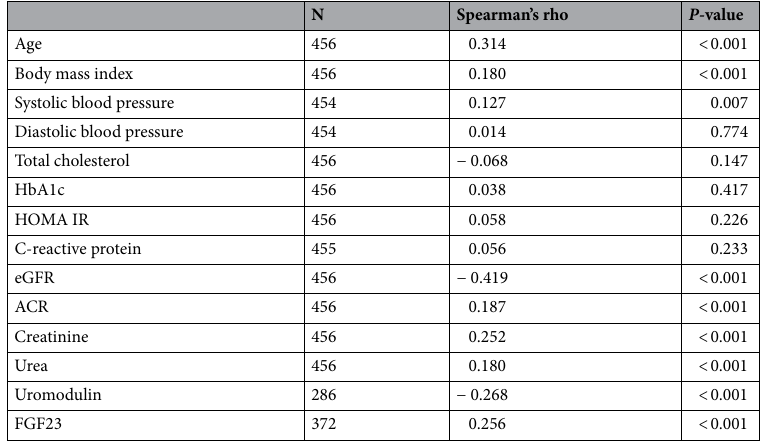
Table 2. Correlation between glypican-4 and baseline clinical and laboratory variables. Association between GPC4 and clinical and laboratory variables were analyzed in accordance with the Spearman rank correlation coefficient analysis. All biomarkers were measured in serum or plasma samples. HbA1c, hemoglobin A1c; HOMA IR, Homeostatic Model Assessment of Insulin Resistance; FGF23, fibroblast growth factor 23.